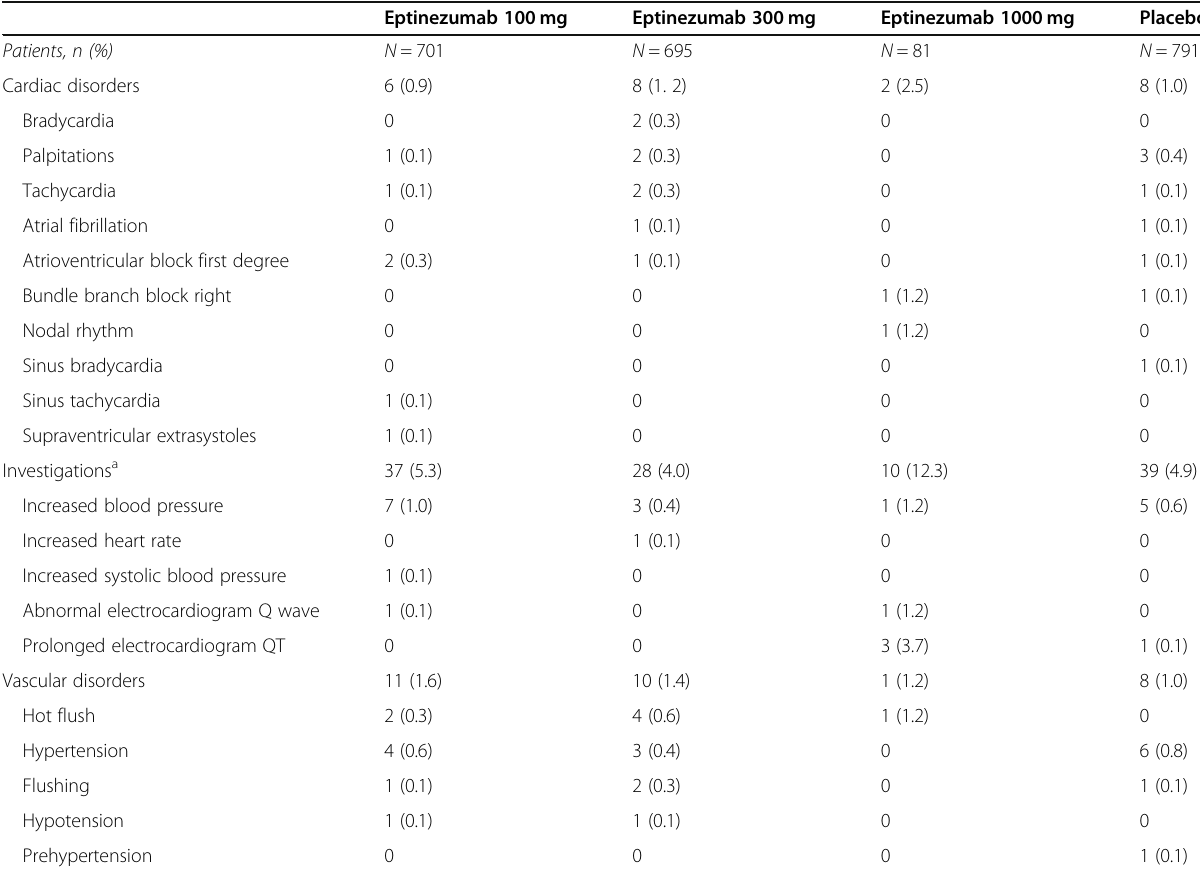
Table 4 Treatment-Emergent Cardiovascular Adverse Events